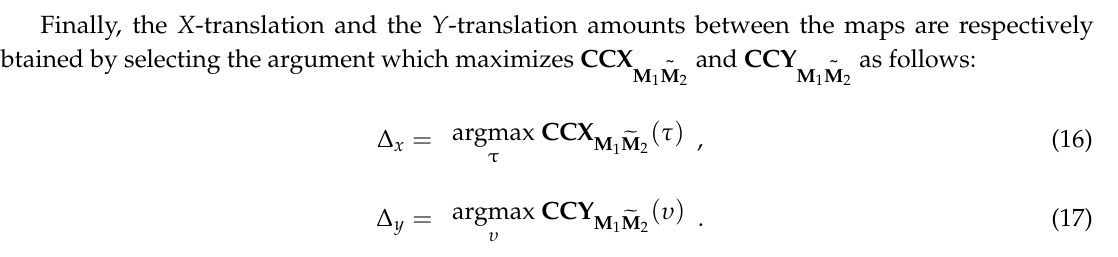
Figure 4. The partial sinograms of M 1 and (cid:101) M 2 for x -axis (left and middle) and their normalized cross-correlation (right). The X -translation amount is estimated by matching the partial sinograms where α (cid:48) = 180 ∘ .